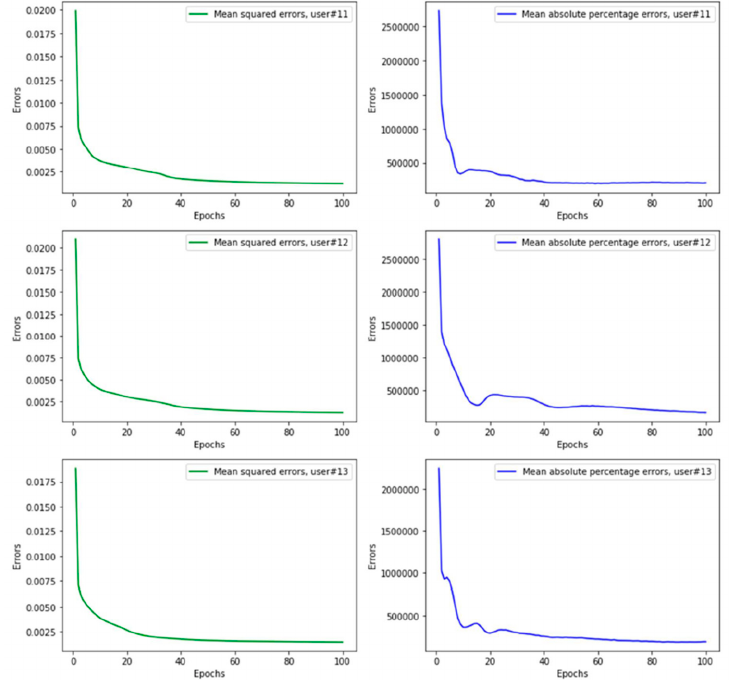
Figure 9. Mean-squared errors and mean absolute percentage errors with respect to 100 epochs from training models during the leave-one-subject-out method for cross-validation of subjects ( top ) 11, ( middle ) 12 and ( bottom ) 13. Table 2. Mean-squared errors (MSE) in watts (W) and relative error (RE) in % for each subject where the other subjects were used for training, using Long Short-Term Memory (LSTM), Convolutional Neural Network (CNN) and Artificial Neural Network (ANN).